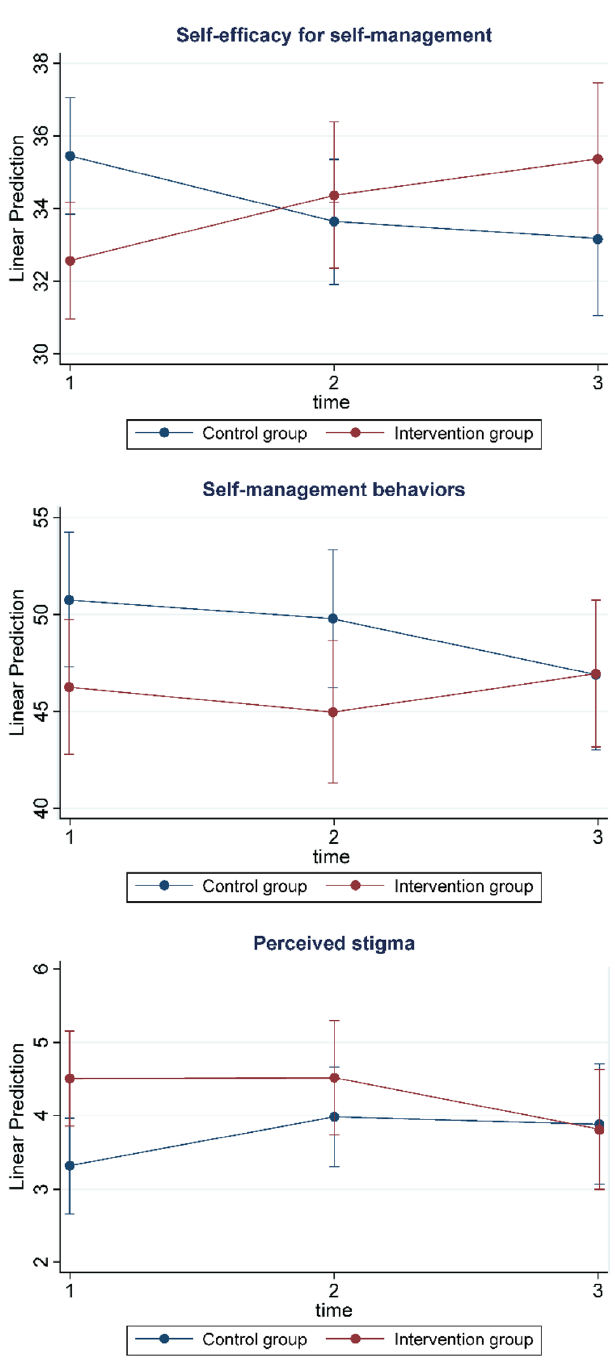
Figure 4. Changes in self-efficacy for self-management, self-management behaviors, and perceived stigma between the two